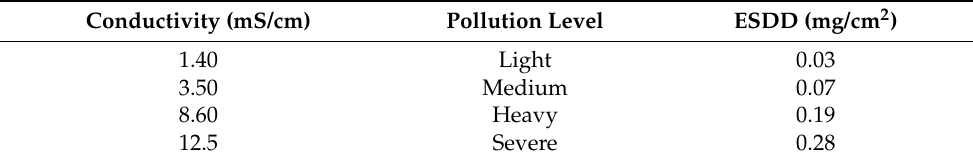
Table 1. Used pollution levels.